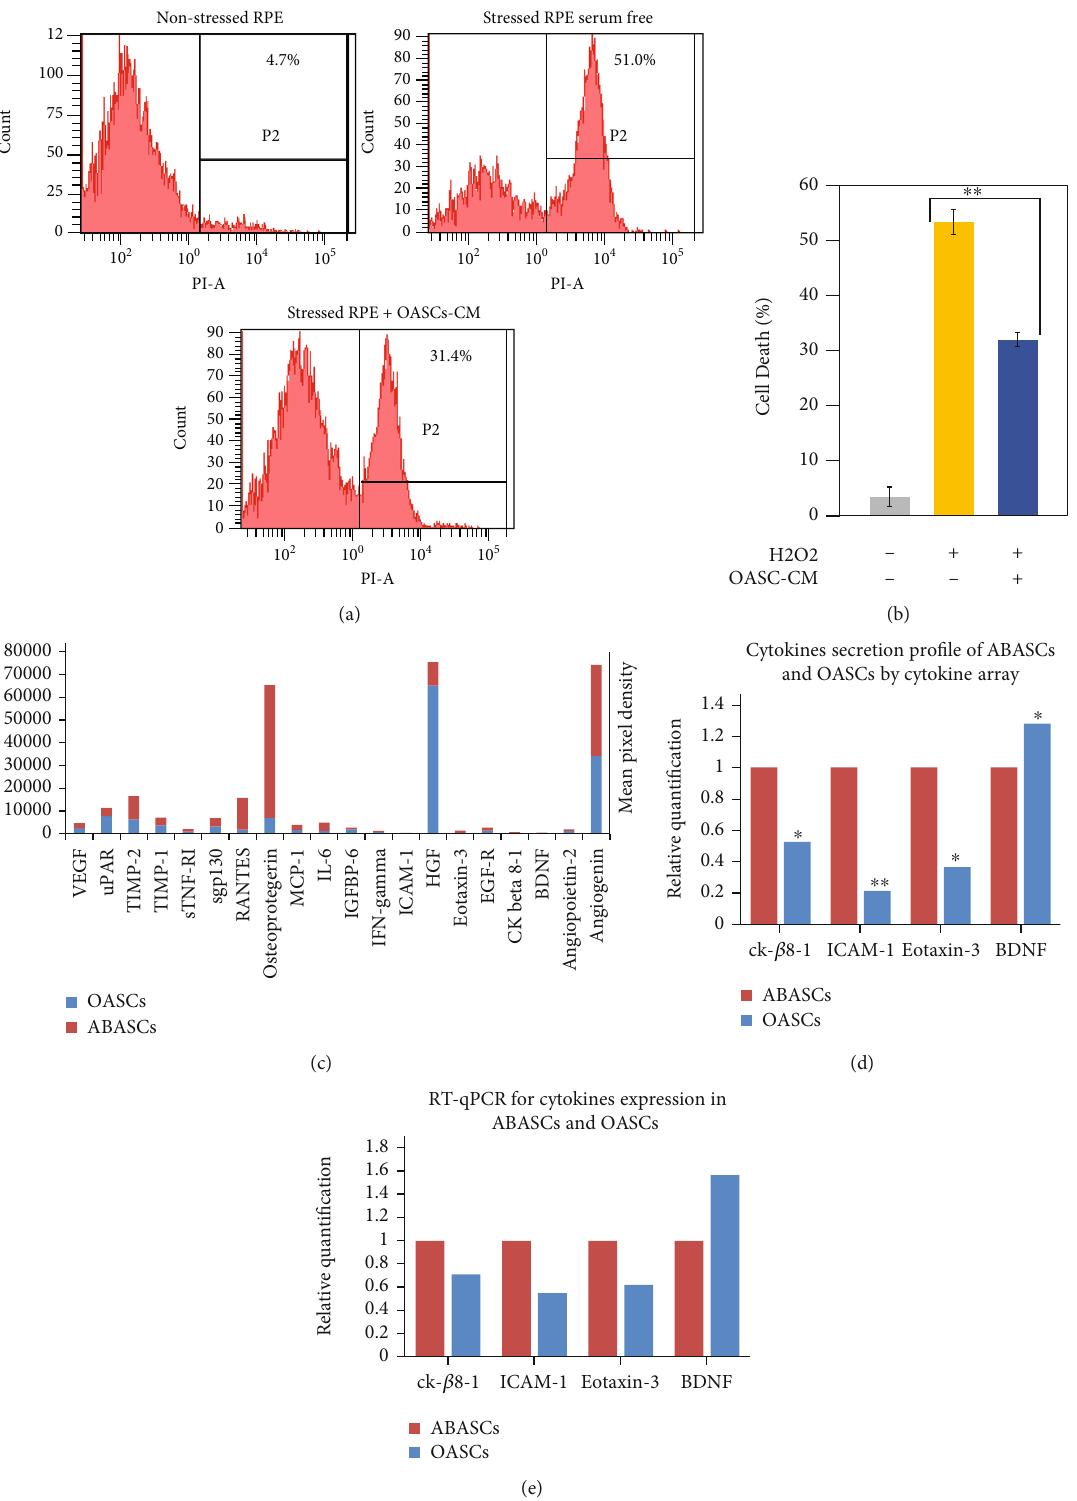
Figure 2: Paracrine activity of OASCs and ABASCs. (a, b) OASCs rescue RPE cells under oxidative stress. RPE cells were incubated with CM or with non-CM for 48 hours, followed by exposure to H2O2 (1 mM, 7h). Cells were harvested, and cell death rate was analyzed by PI staining followed by fl ow cytometer analysis. Data are represented as mean ± SD . (c) Medium containing secreted protein of OASCs and ABASCs was examined using RayBio® Human Cytokine Antibody Array G10. Cytokine array membranes used to analyze the secretion of 20 cytokines by OASCs and ABASCs. (d) Summary of signi fi cant released proteins elevated in OASCs compared to ABASCs. (e) Gene expression of these proteins in OASCs compared to ABASCs. CM: condition